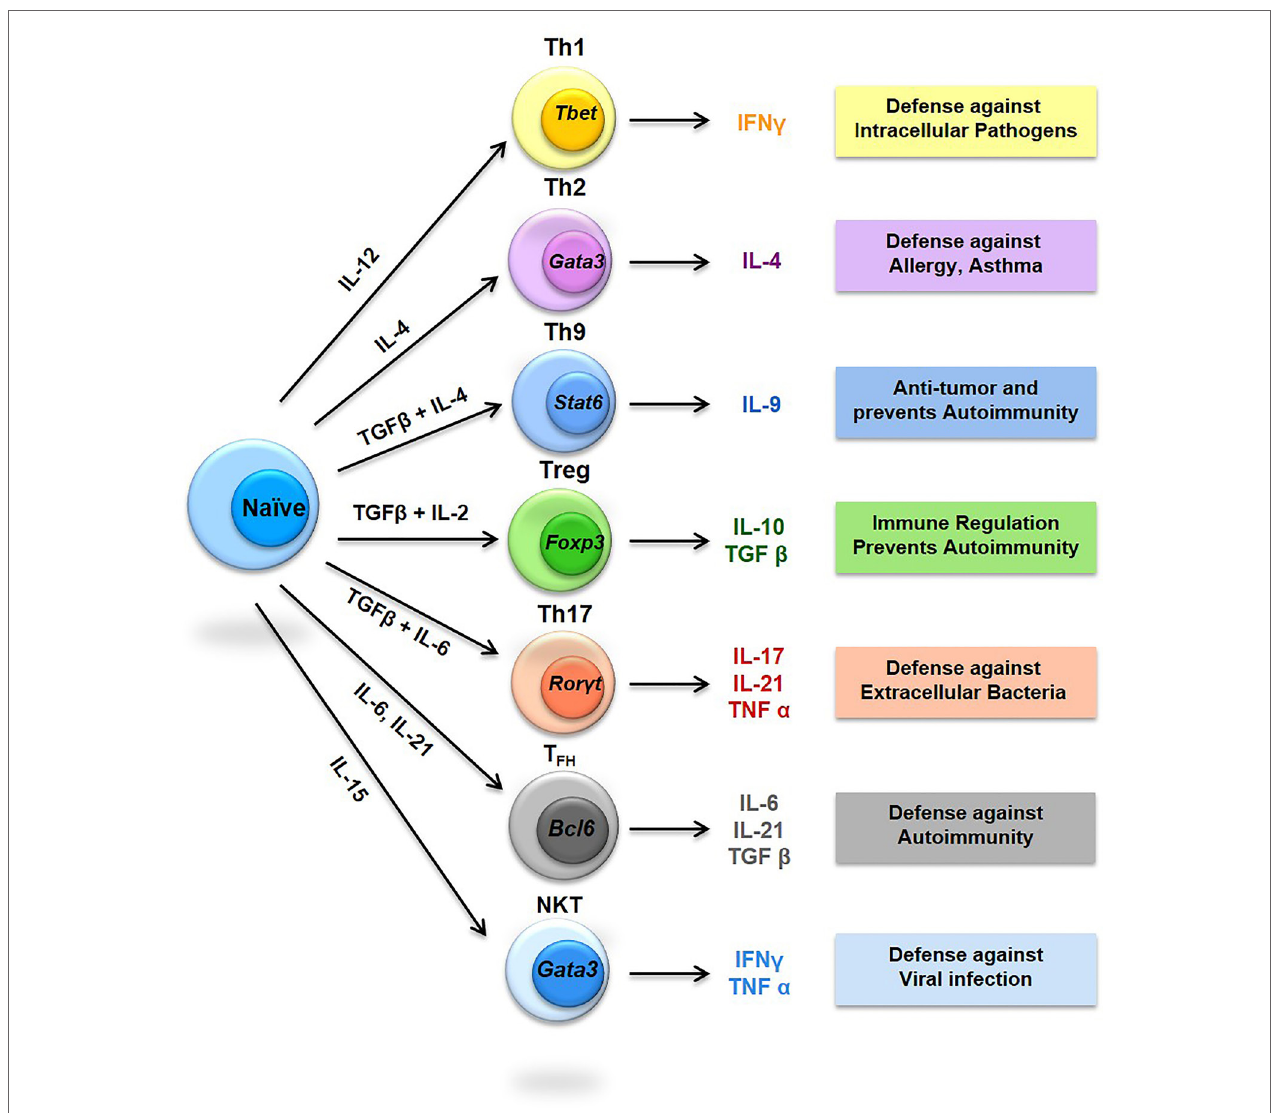
FigURe 2 | Diversity of T helper (Th) cells. The signature cytokines produced by respective Th cells are shown along with their immunomodulatory properties in boxes. STAT, Signal transducer and activator of transcription; ROR γ , RAR-related orphan receptor gamma; Foxp3, Forkhead box P3; BCL6, B-cell lymphoma